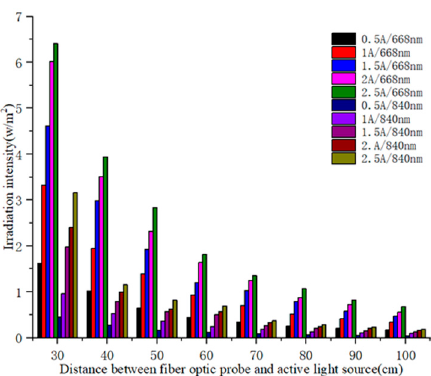
Figure 6. Relationship between the irradiation intensity and driving current and projection distance.